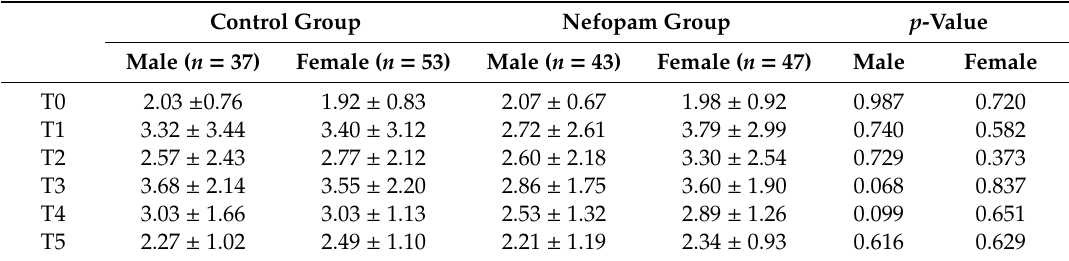
Table 3. Association between sex and VAS at each time